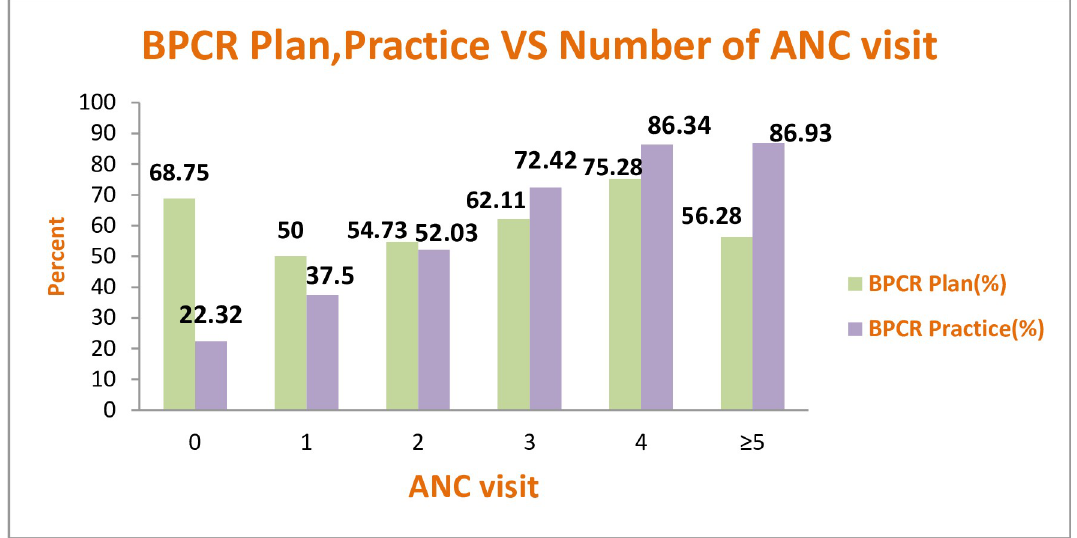
Fig 2. BPCR plan and practice versus number of antenatal care visits among pregnant women in North Gondar Zone, Northwest Ethiopia, 2018.